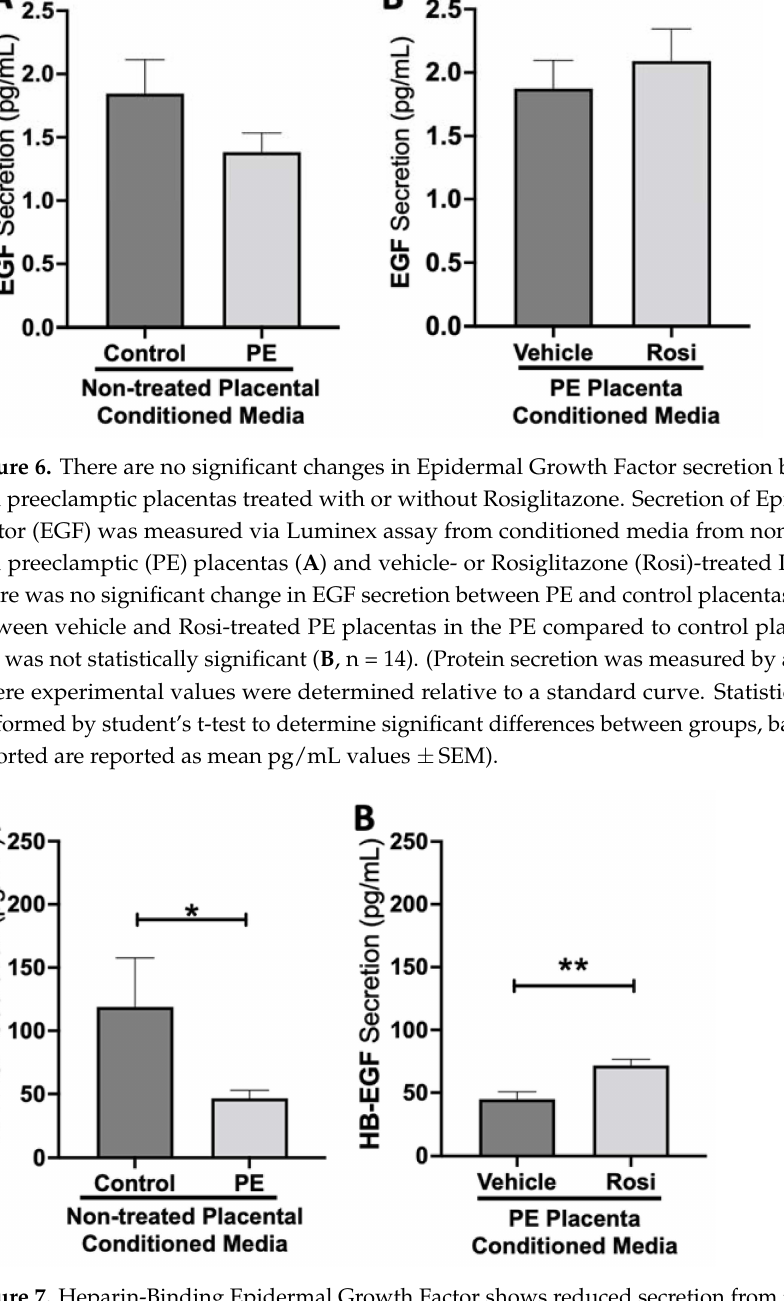
Figure 7. Heparin-Binding Epidermal Growth Factor shows reduced secretion from the preeclamptic placenta but is reversed by Rosiglitazone treatment. Secretion of Heparin-Binding Epidermal Growth Factor (HB-EGF) was measured via Luminex assay from conditioned media from non-treated control and preeclamptic (PE) placentas ( A ) and vehicle- or Rosiglitazone (Rosi)-treated PE placentas ( B ). There was a significant reduction of HB-EGF secretion from the PE placenta compared to control ( A , n > 6). Rosi-treated PE placentas show a significant increase in HB-EGF secretion compared to the vehicle control ( B , n = 10). (Protein secretion was measured by a Luminex assay where experimental values were determined relative to a standard curve. Statistical analysis was performed by student’s t -test to determine significant differences between groups, * p < 0.05, ** p < 0.01, bar plots and data reported are reported as mean pg/mL values ±